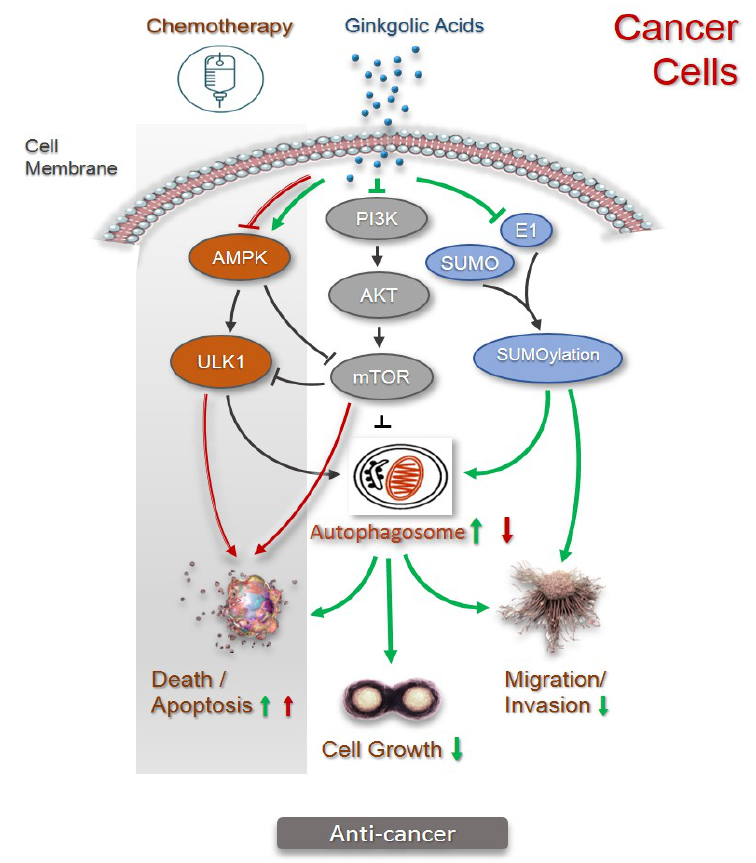
Figure 6. Role of autophagy in mechanisms for pharmacological activities of ginkgolic acids in cancer cells. As the key regulators, the PI3K/Akt/mTOR signaling pathway negatively and the AMPK/ULK1 signaling pathway positively regulate autophagy (illustrated in black). Through inhibition of PI3K/Akt/mTOR pathway and activation of AMPK/ULK1 pathway, ginkgolic acids upregulate autophagy (illustrated in green). SUMOylation is activated by SUMO-activating enzyme (E1)-initiated cascade that adds SUMO peptides to targeted proteins (illustrated in black). Functioning as SUMO1-specific inhibitor, ginkgolic acids inhibit SUMOylation, thus suppressing migration and invasion of cancer cells. Activation of autophagy by ginkgolic acids inhibits cancer cell growth, migration, and invasion and promotes cancer cell death (illustrated in green). When co-administered with chemotherapy, ginkgolic acids sensitize the cancer cells to chemotherapy by suppressing the chemotherapy-induced autophagy by inhibiting the AMPK/ULK1 pathway and/or stimulating chemotherapy-induced apoptosis via inhibition of PI3K/Akt/mTOR pathway (illustrated in